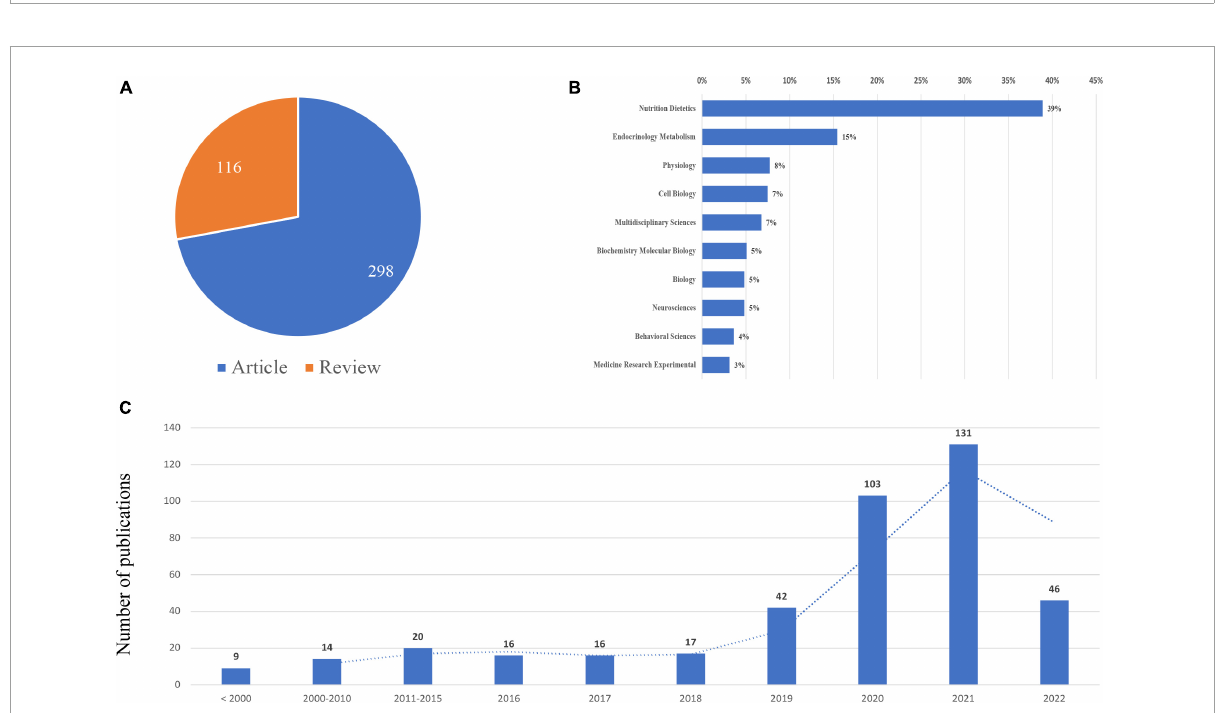
FIGURE2 Yearly quantity and literature type of publications on time-restricted eating (TRE) from inception to May 1, 2022. (A) Literature types distribution. (B) Subject categories distribution. (C) Annual publications quantitative distribution.